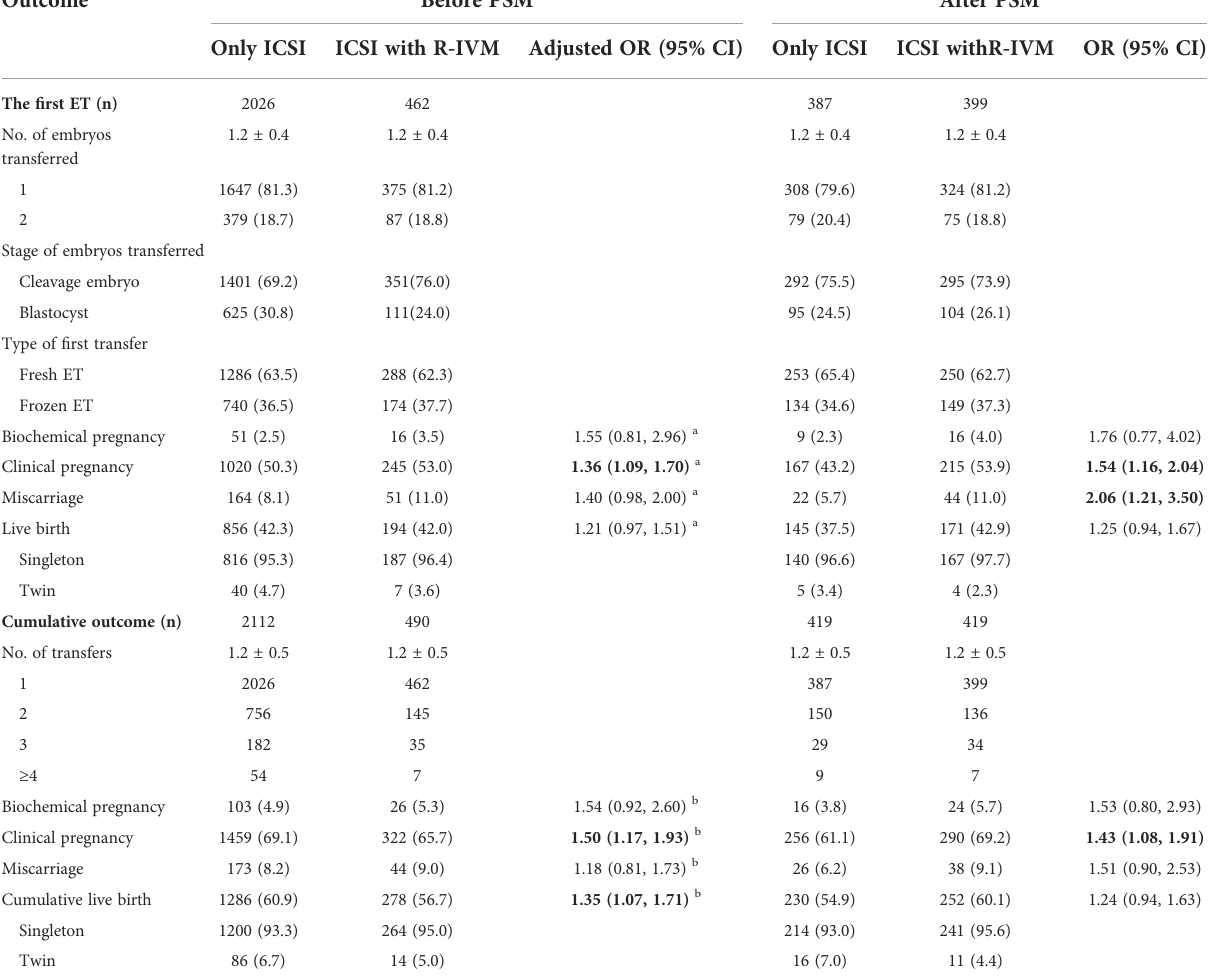
TABLE 3 Pregnancy outcomes of women undergoing only ICSI versus women undergoing ICSI with R-IVM. Outcome